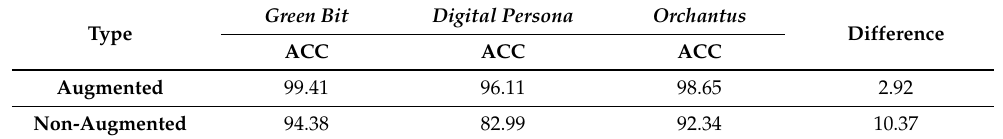
Table 6. The performance comparison between augmented and non-augmented